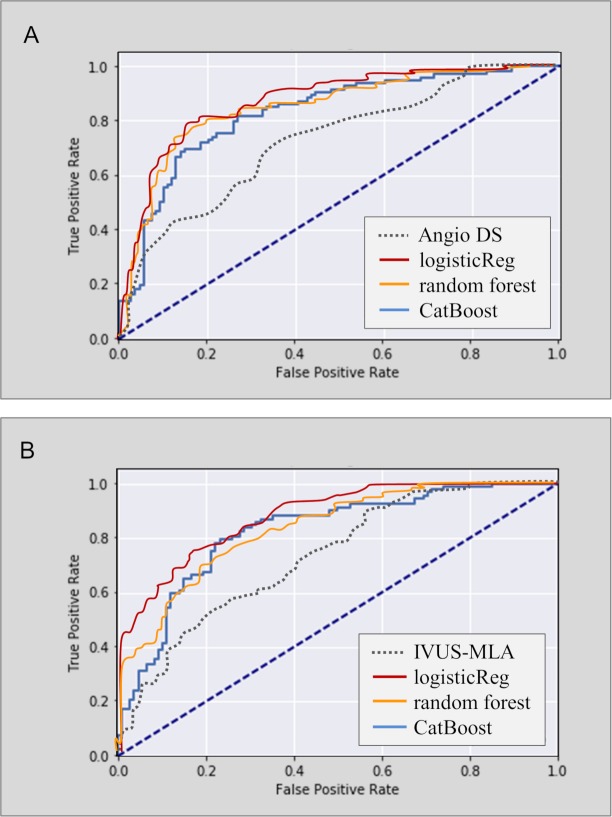
ROC analyses for predicting FFR < 0.80 in the test sample (N = 200).(A) The ML models using angiographic features showed greater AUCs (0.83–0.86) than did the angiographic DS alone (AUC = 0.71). (B) The ML models using both angiographic features and IVUS-MLA showed larger AUC (0.82–0.87) than did the IVUS-MLA alone (AUC = 0.72). AUC, area under the curve; DS, diameter stenosis; FFR, fractional flow reserve; IVUS-MLA, intravascular ultrasound–derived minimal lumen area; ML, machine learning; ROC, receiver operating curve.